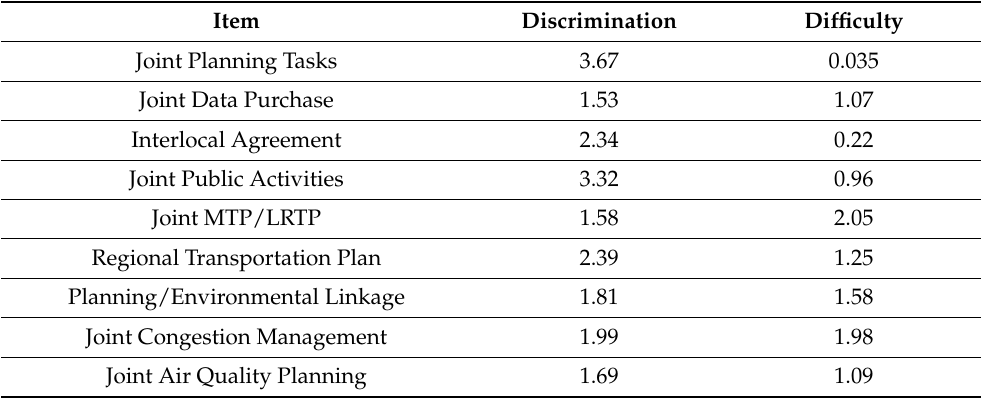
Table 2. Item response scores.